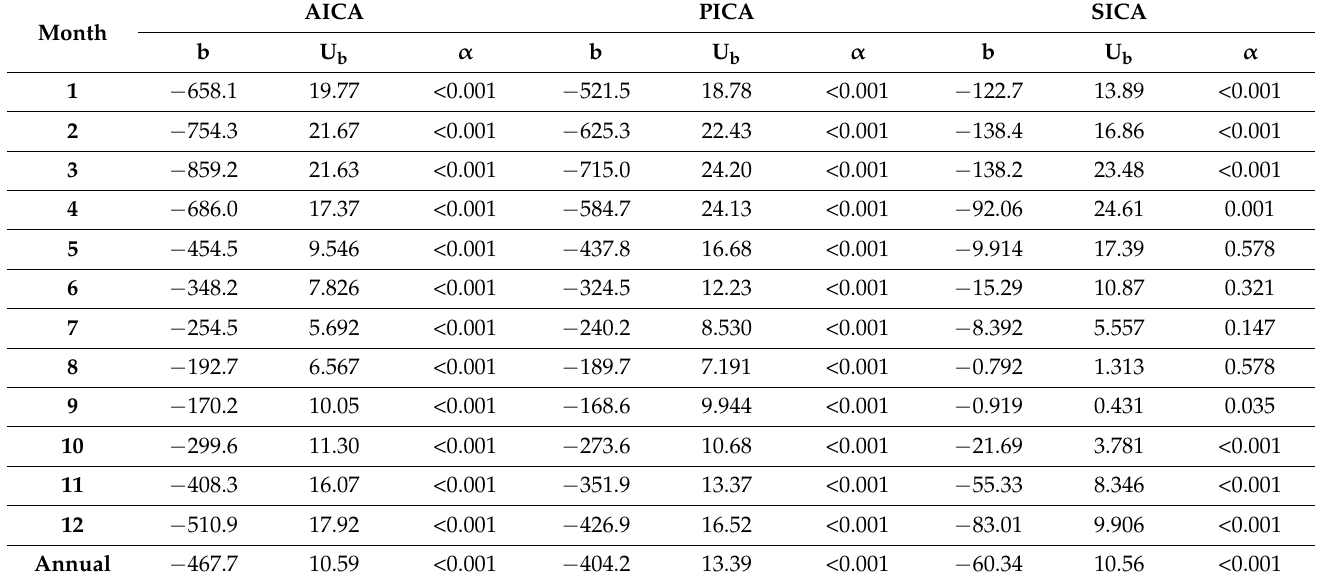
Table 4. Monthly mean SIV trend b (km 3 per year) with its uncertainty U b and confidence level α for AICA, PICA, and SICA over 1982–2020.